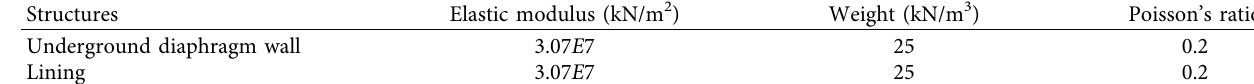
Table 2: Structural parameters and mechanical parameters.